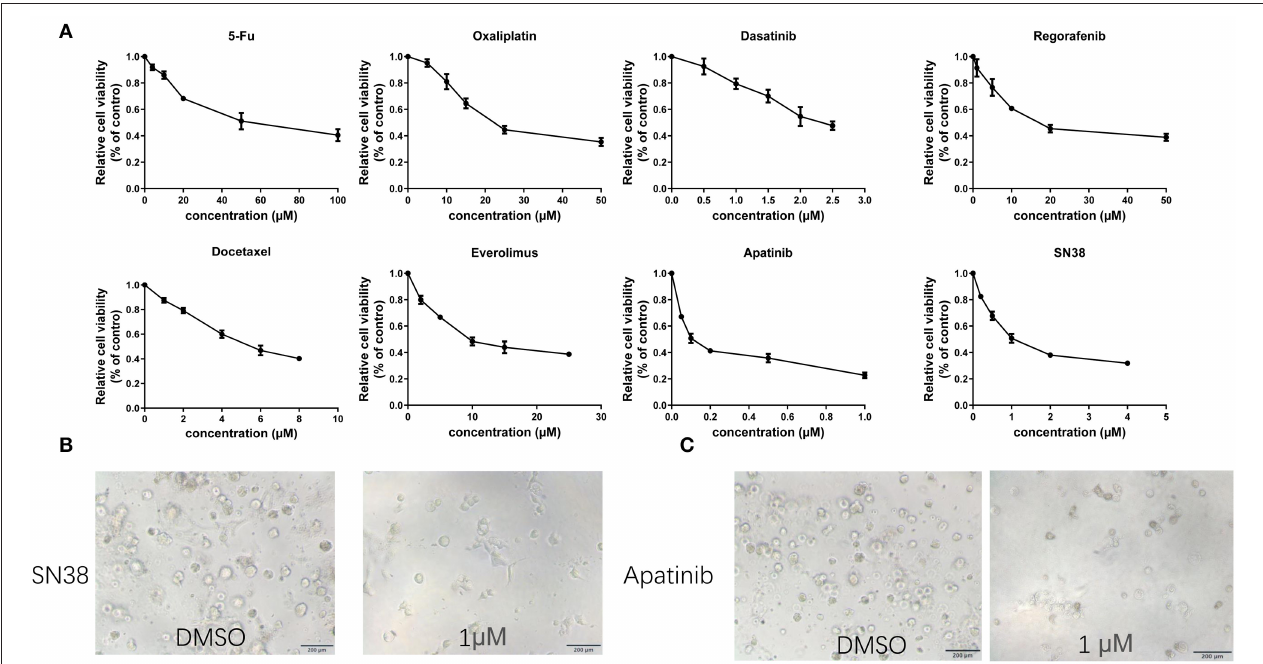
FIGURE 5 | Representative images and drug tests of the organoids. (A) Dose-response curves of organoids treated with 5-FU, oxaliplatin, SN38, apatinib, dasatinib, docetaxel, regorafenib and everolimus. (B) Mean ± SD of results from three independent experiments is shown for each drug. (C) Representative images of the organoid after treatment with 1 µ M SN38 and DMSO. Organoid treated with 1 µ M apatinib and DMSO. Scale bar = 200 µ